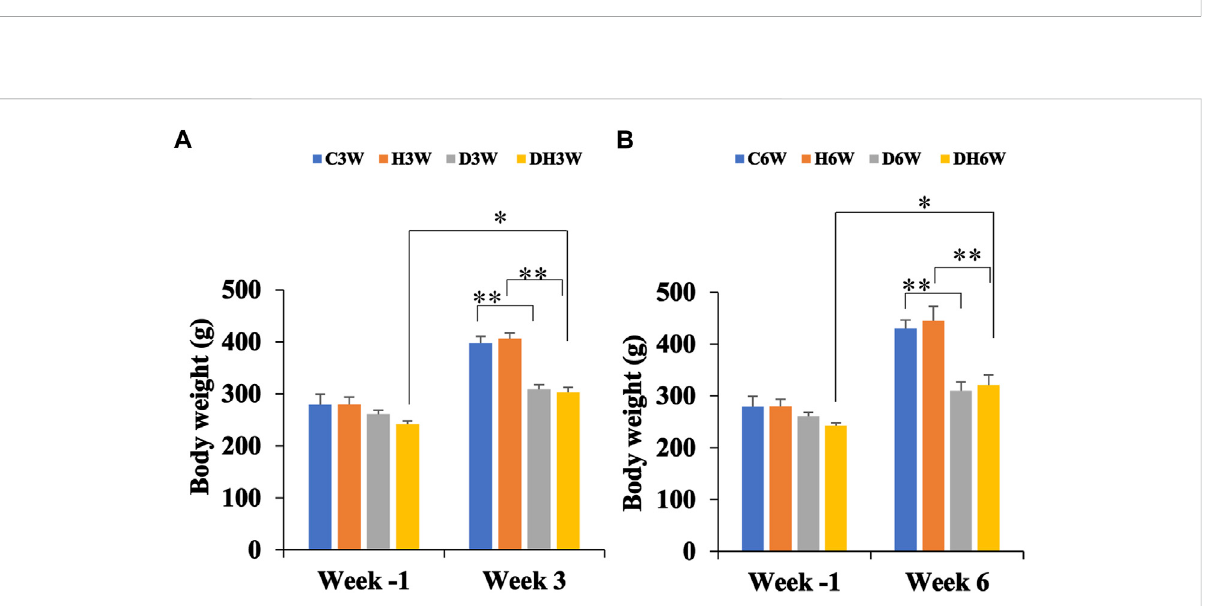
FIGURE 2 Body weight of rats in different groups in short-term (A) and long-term (B) experiments. Note there were no signi fi cant differences in body weight between groups at week-1 in both short and long term experiments. However, there was a signi fi cant decrease in the body weight of rats in diabetic and diabetic + heat therapy groups (D3W, DH3W, D6W, and DH6W) compared to respective control groups both in short and long-term experiments (** p < 0.01, One-way ANOVA, Bonferroni multiple comparison tests, n = 6 in all groups). There was no signi fi cant difference in body weight loss when compared between diabetic and diabetic + heat therapy groups in both short and long-term experiments. Body weight gain was signi fi cantly high in DH3W and DH6W compared to their Week-1 body weight (*, p <